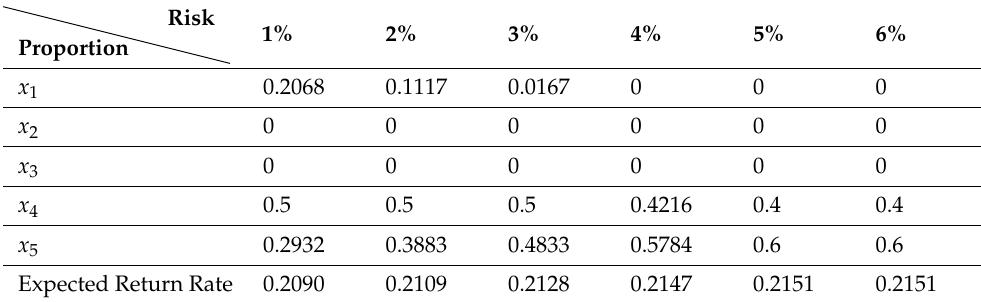
Table 3. An efficient portfolio in the guaranteed return rate (cid:101) p 3 .